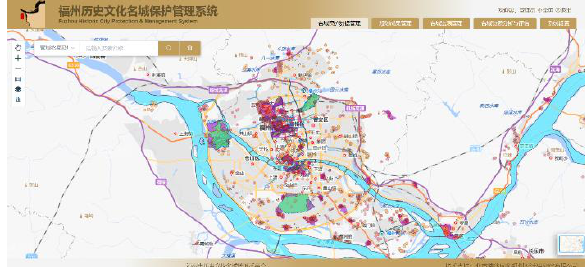
Figure 3. All-in-one Map rending all the urban heritage and conservation zoning of Fuzhou